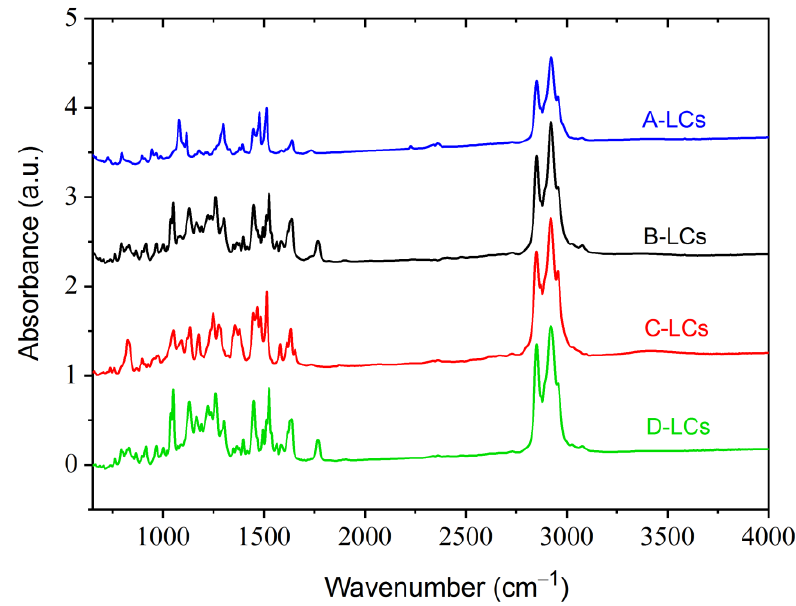
Figure 5. FTIR results from LC mixtures of LCDs A, B, C and D.